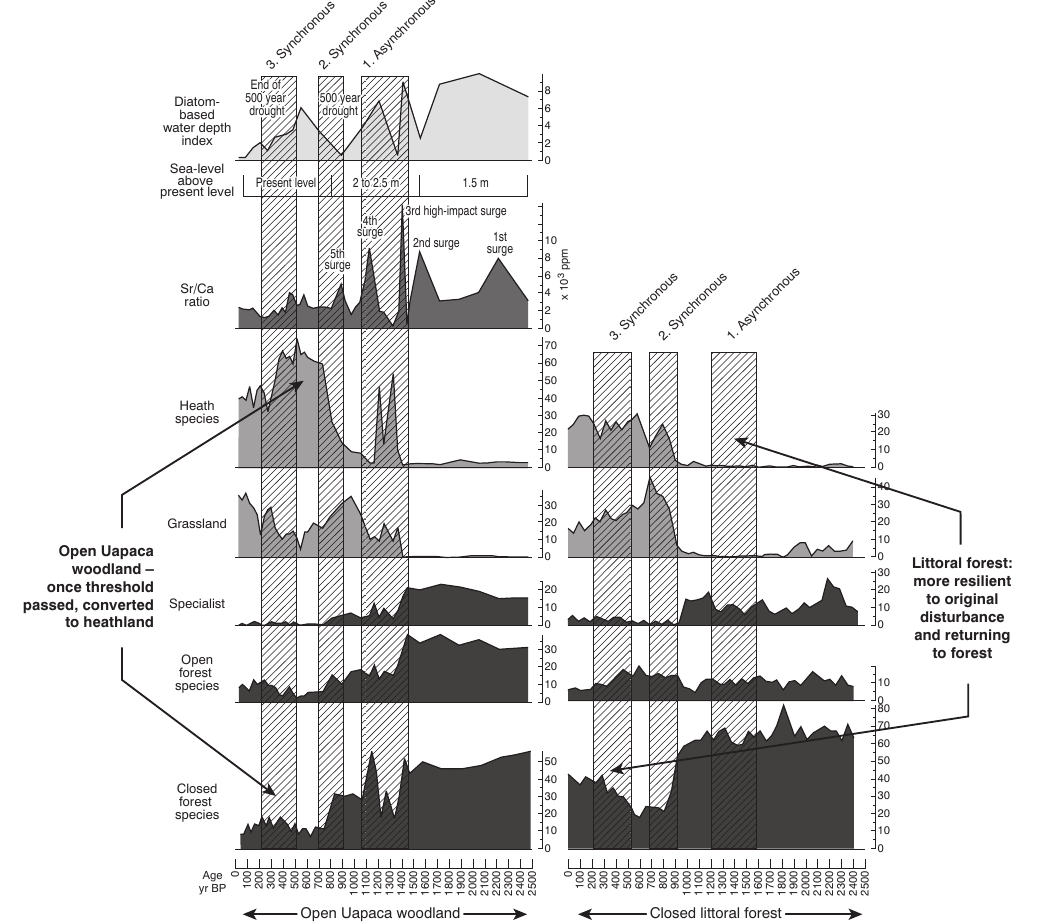
Fig. 2. Changes in selected taxa at the two habitat types: (a) Erica-heath (left hand panel) and (b) littoral forest fragment (right hand panel). Grey bands are periods of abiotic changes corresponding to vegetation shifts. Note the difference in species composition and timing of changes between the two sites (Redrawn from Virah-Swamy et al.,